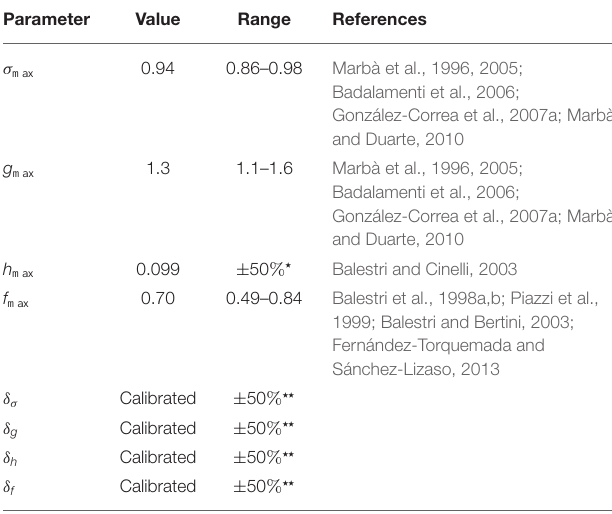
TABLE 1 | Reference parameter values for the P. oceanica metapopulation model in the Mediterranean Sea.